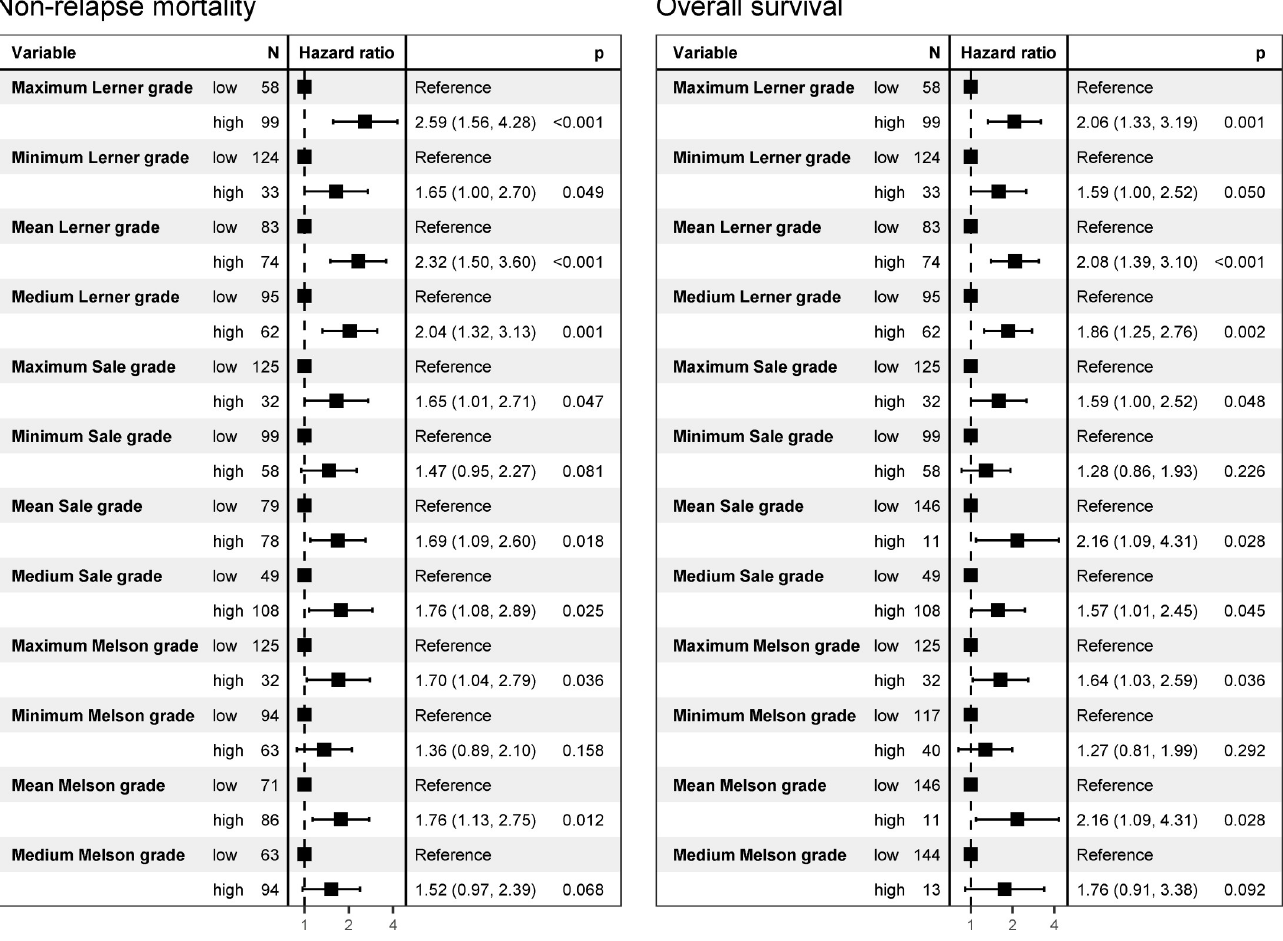
PLOS ONE | https://doi.org/10.1371/journal.pone.0256543 August 26,